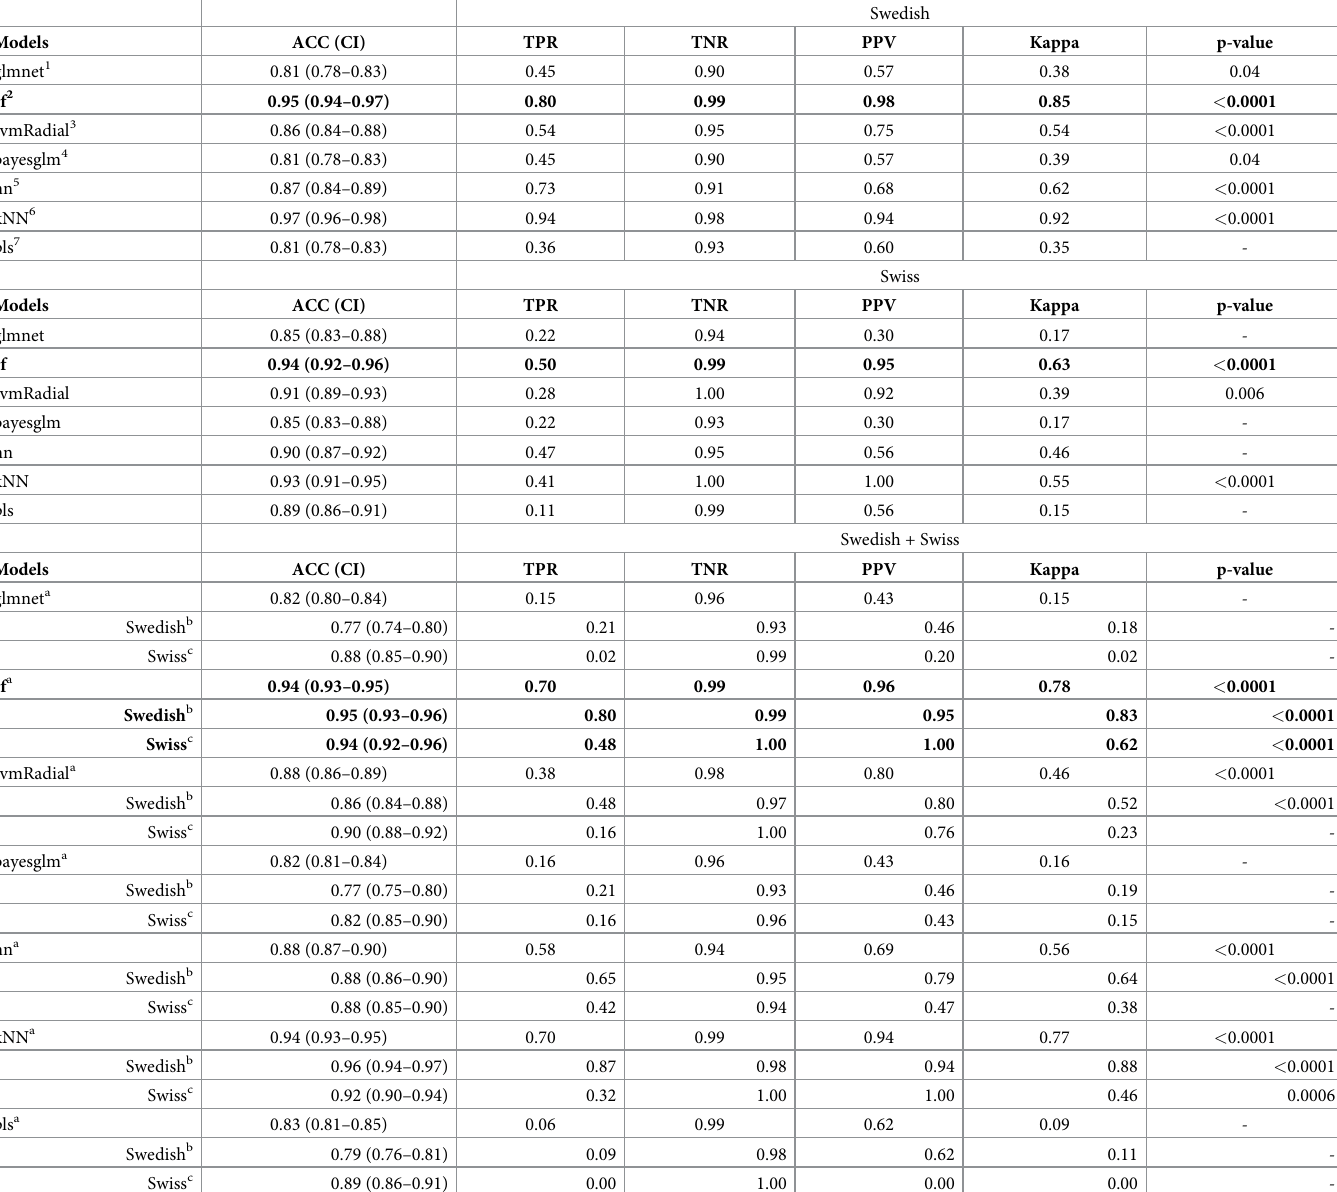
Table 6. Performances of models to predict unseen analysis windows [cross validation (CV) approach] of the Swedish, Swiss and Swedish+Swiss testing data sets.